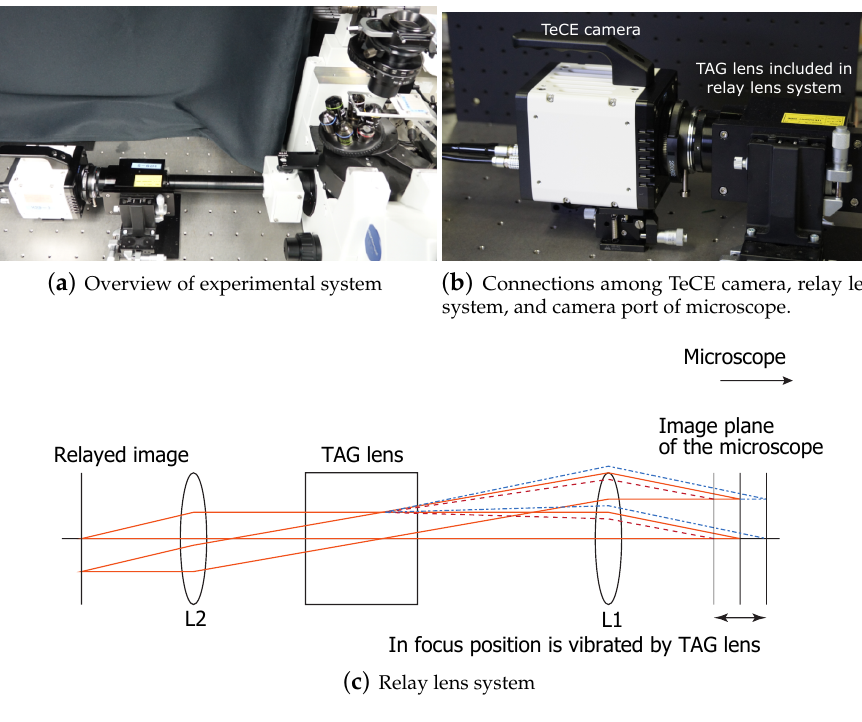
Figure 3. Components of experimental